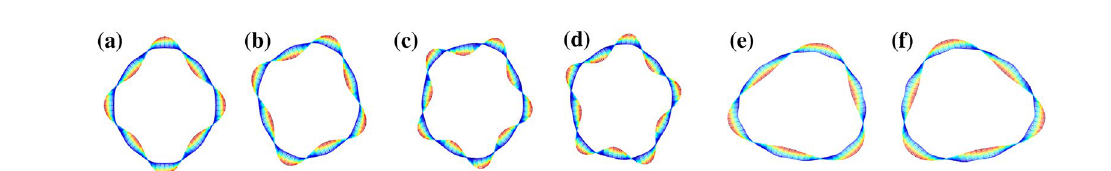
Figure 9 Mode shapes of the cylindrical shell with a random mistuned restraint stiffness sample with σ k order; c the third order; d the forth order; e the fifth order; f the sixth order